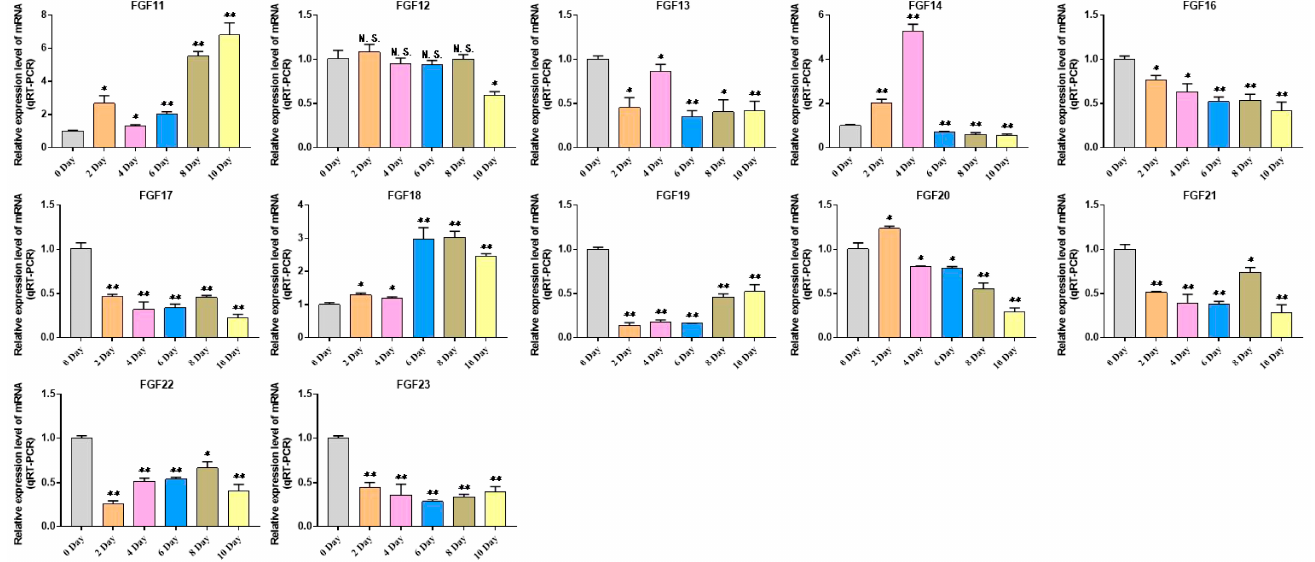
Figure 8. Detection of FGFs gene expression during adipocyte differentiation. Compared with the control, “*” means a significant difference ( p < 0.05), “**” means an extremely significant difference ( p < 0.01), and “N.S.” indicates a non-signi fi cant di ff erence.